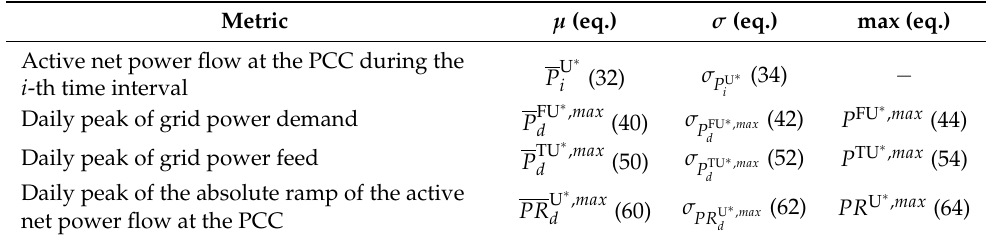
Table 4. Summary of the metrics and reference to the related equations adopted to analyze the net power profiles at the PCC with the utility for Scenario B, i.e., with PV and without storage. µ : average value, σ : standard deviation, max: maximum value.